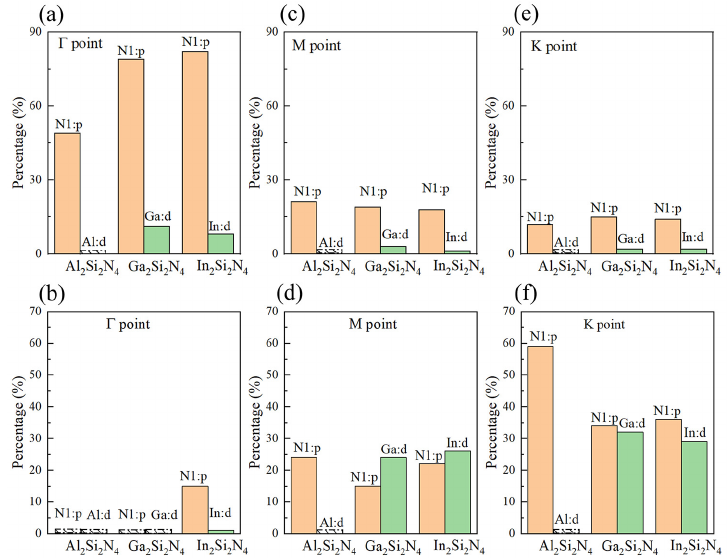
Figure 5. Atomic orbital components of the highest valence band and the lowest conduction band at Γ , ( a , b ) M ( c , d ) and K points ( e , f ). The blank boxes indicate